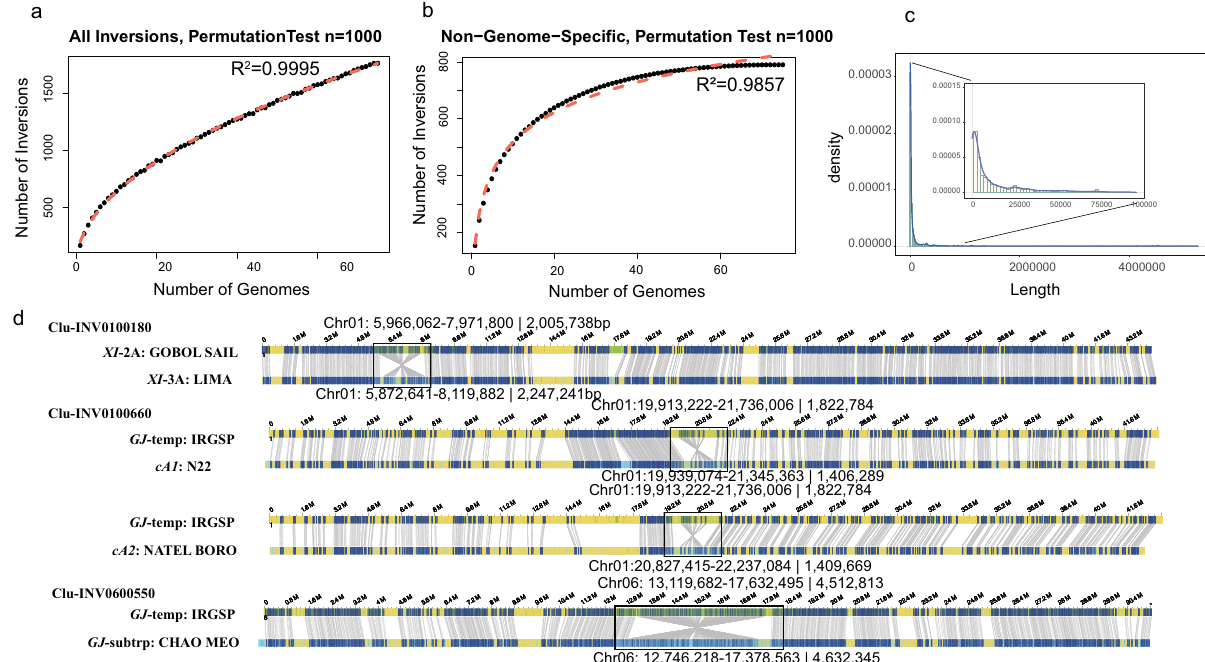
Fig. 1 | Rice inversion index summary. a , b Resampling permutation test to identify the relationship between the number of genomes and all inversions and shared (non-genome speci fi c) inversions, respectively; c Density of inversion lengths; d Bionano validation of inversions larger than 1Mb, i.e., Clu-INV0100180, Clu-INV0100660, and Clu-INV0600550. In each panel, the top line shows the